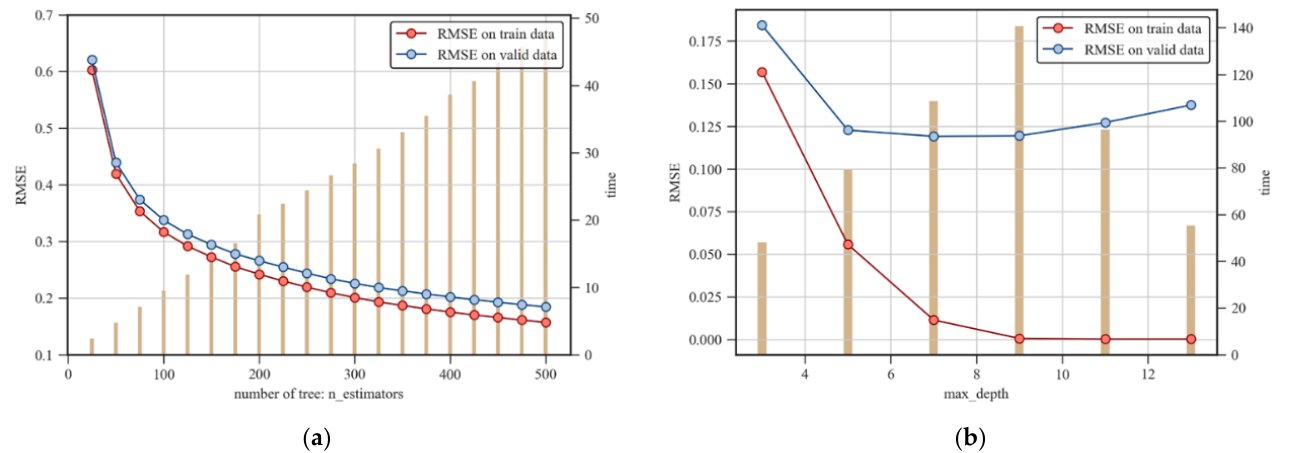
Figure 18. Tuning the hyperparameters of the GBDT model. ( a ) n_estimators; ( b ) max_depth.